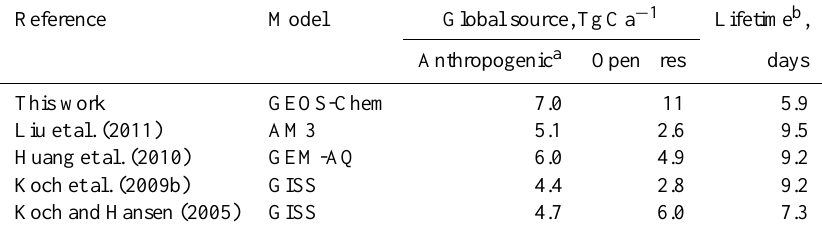
Table 2. Global model representations of atmospheric